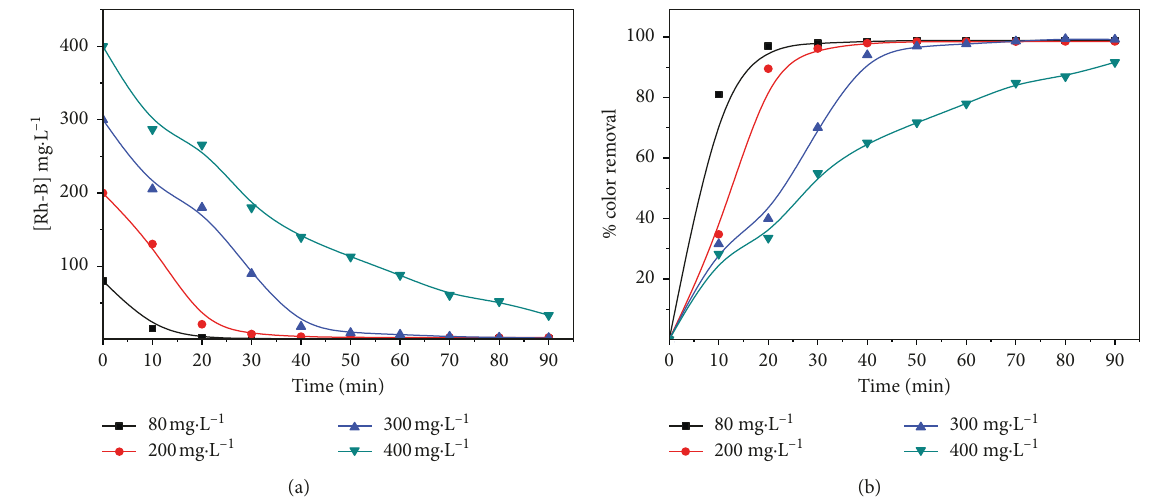
Figure 8: Effect of initial concentration on the Rh-B dye removal. Conditions: current density, 3.9mA · cm − 2 ; [NaCl], 0.07mol · L − 1 ; T , 25 ° C; flow rate, 30L · h − 1